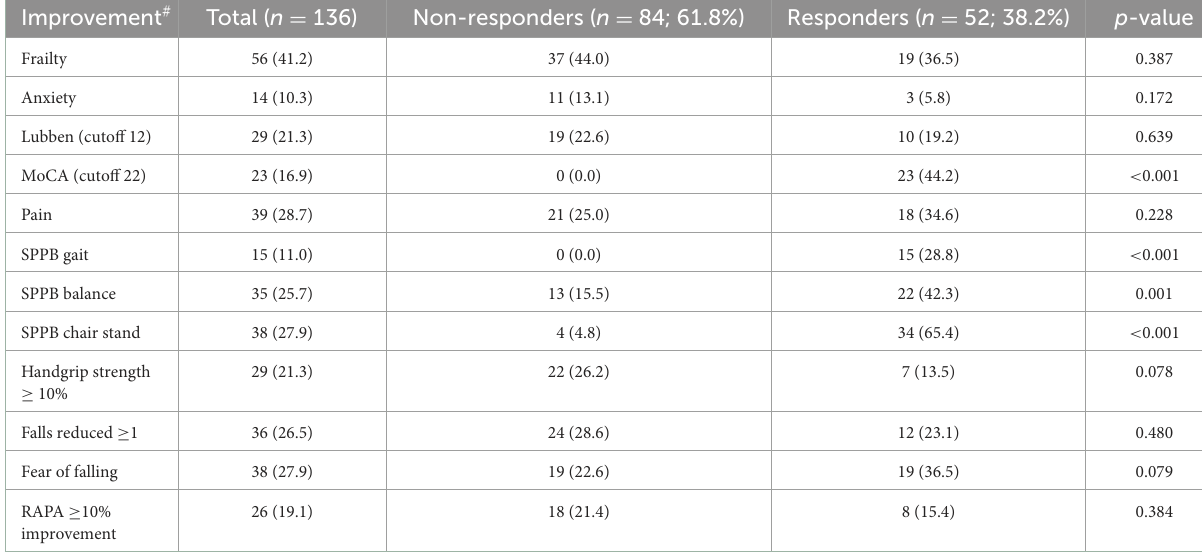
TABLE 2 Variables used in latent class